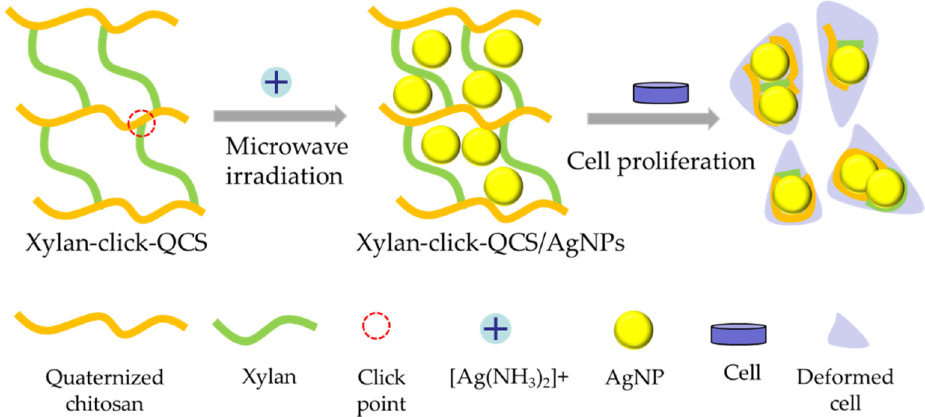
Figure 1. Fabrication process of xylan-click-QCS/AgNPs and its influence on cancer